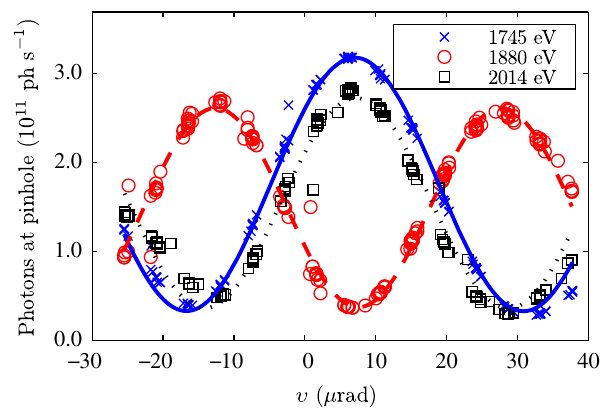
FIG. 6. Measured pinhole photon flux fitted for orbit bumps through the undulator. Measured data at harmonics n ¼ 13 , 14, and 15 are fitted by parabolas, with the 1 σ statistical distribution of measured data points illustrated [30].